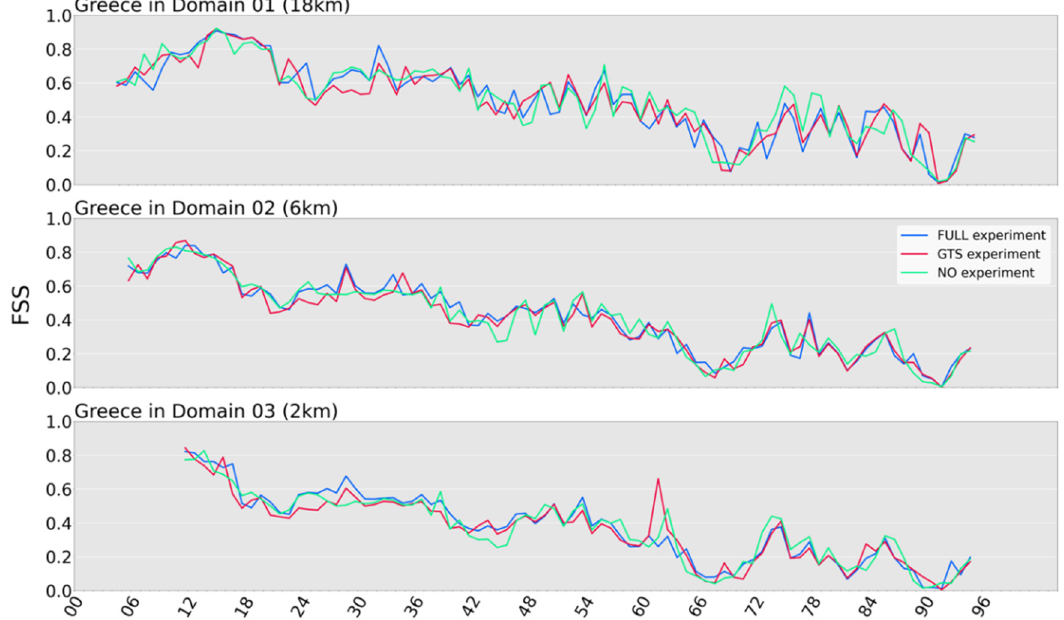
Figure 11. Hourly time series of precipitation accumulation mean FSS for the area of Greece. Each panel refers to a specific spatial resolution domain and the scores achieved for each type of experiment (i.e., FULL, GTS, NO). The blue lines represent the FULL experiment, the GTS experiment is depicted in red, and the NO experiment is depicted in colors.